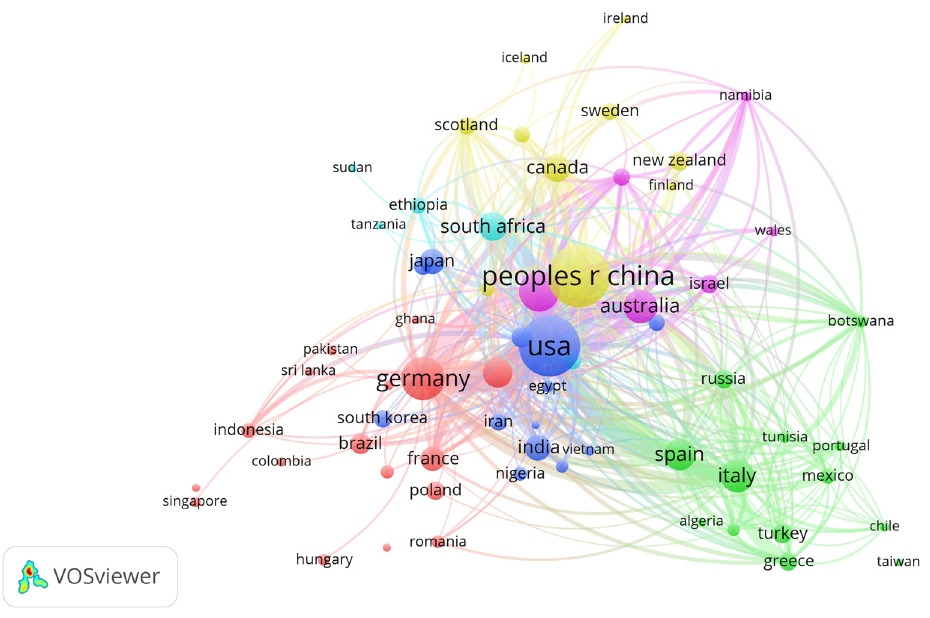
Figure 8. Country collaboration map of the countries in the field of land degradation.